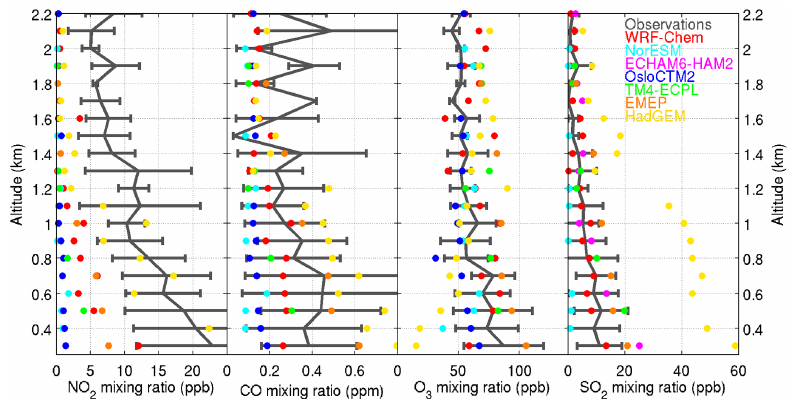
Figure 6. Mean vertical profiles of ozone, NO 2 , CO and SO 2 observed over China during the CAREBEIJING 2008 airborne campaign and simulated by the ECLIPSE